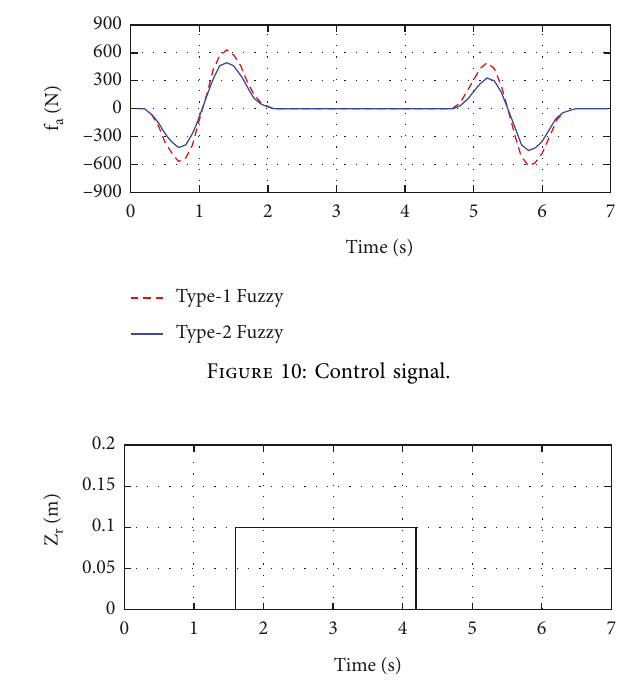
Figure 11: Terrain of the road 2.